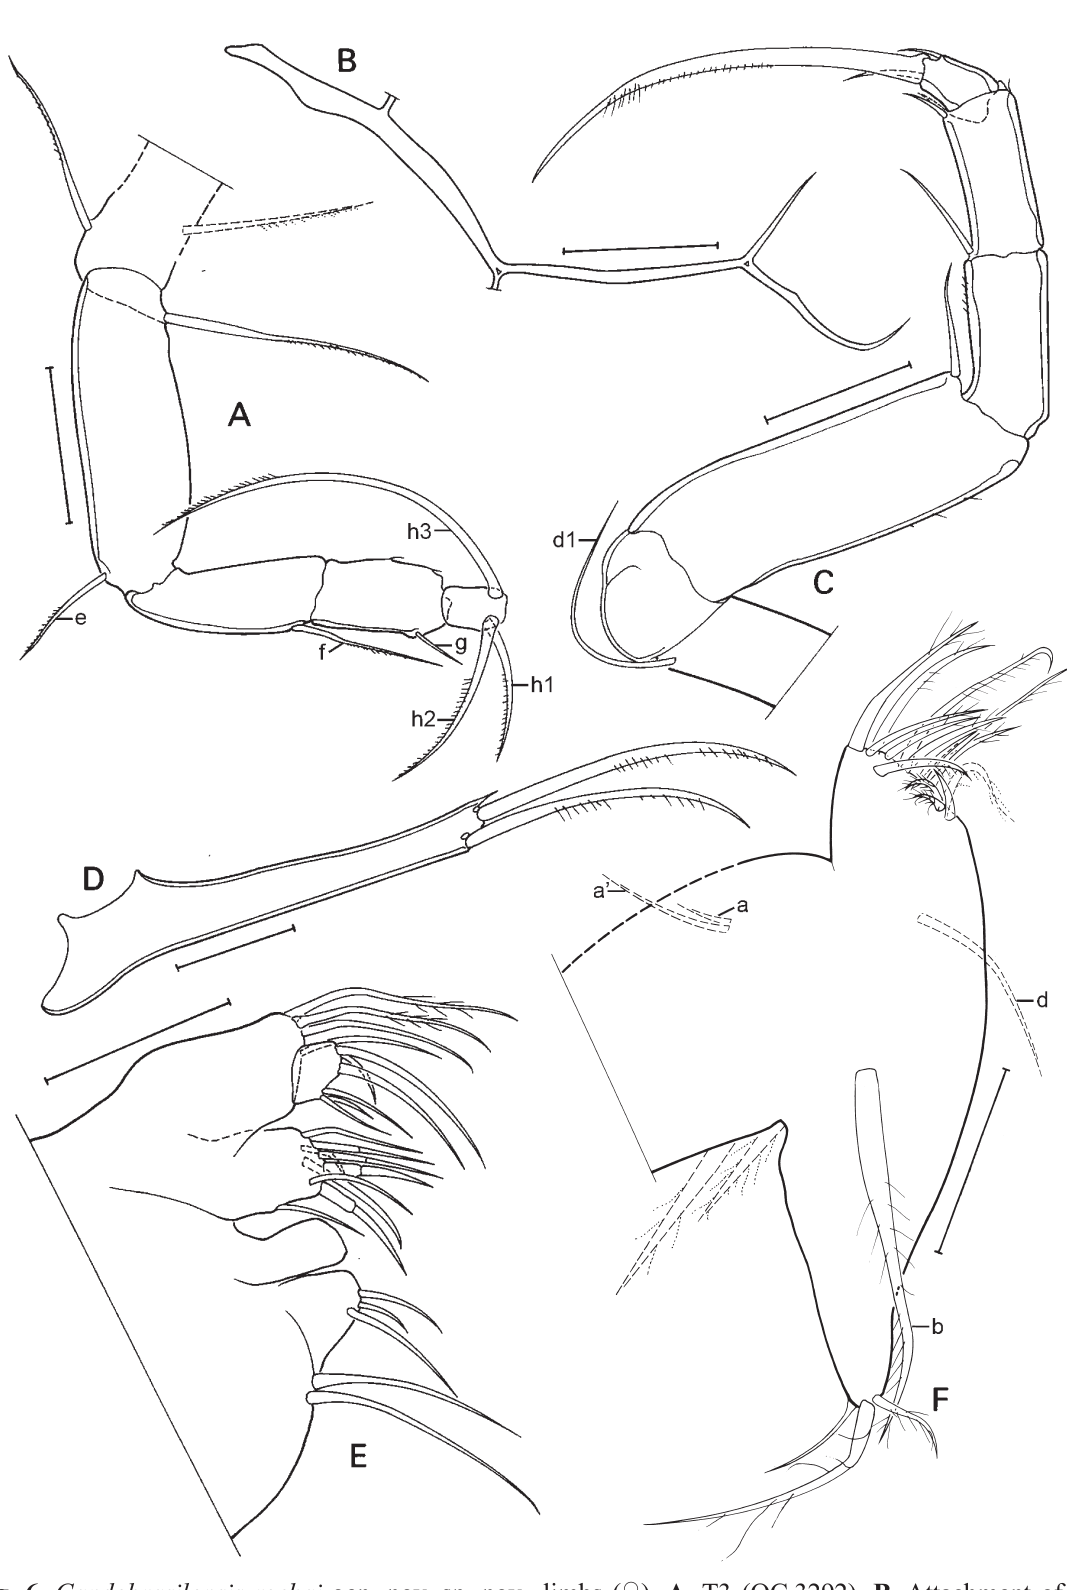
Fig. 6. Candobrasilopsis rochai gen. nov. sp. nov., limbs (♀). A . T3 (OC.3292). B . Attachment of the caudal ramus (MZUSP.28110). C . T2 (MZUSP.28109). D . Caudal ramus (OC.3292). E . Mx1 (Chaetotaxy incomplete) (OC.3292). F . T1 (MZUSP.28111). Scale bars: A-F = 50